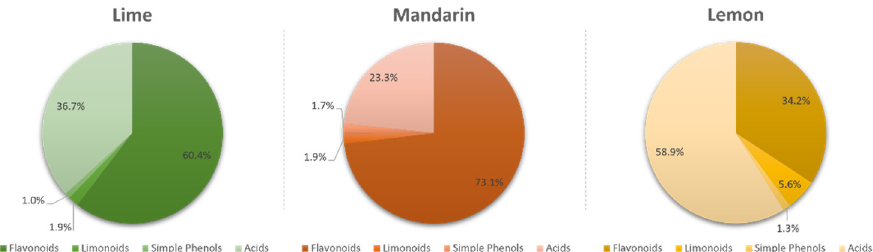
Figure 1. Proportion of flavonoids, limonoids, simple phenols, and carboxylic acids in limes, man- darins, and lemons.